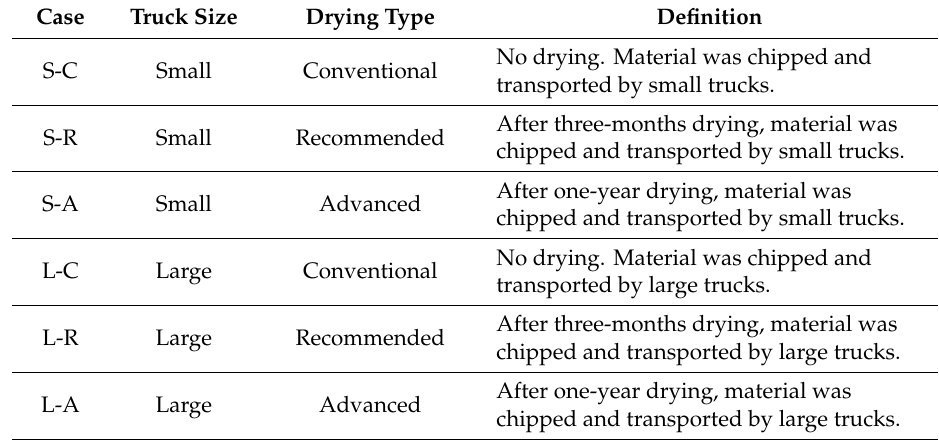
Table 2. Summary of simulation cases.